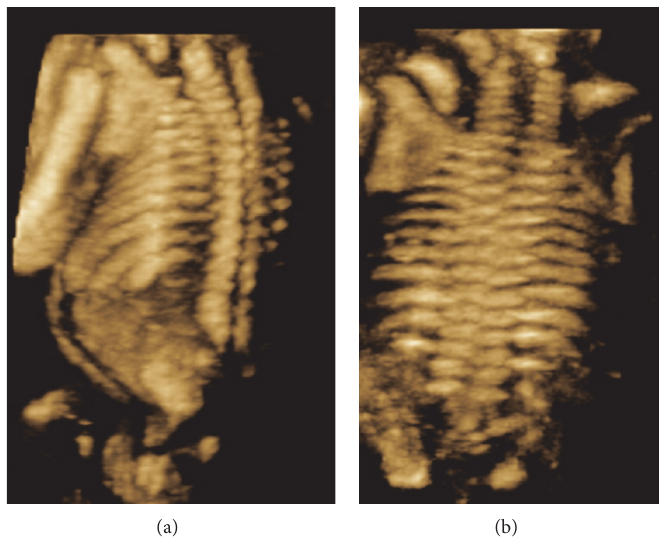
Figure 1: Three-dimensional US scans. (a) 3D rendered image of a lateral view of left upper arm, scapula, chest, and spine. The spine ends abruptly at low lumbar level and appears disconnected from the pelvic bones. (b) 3D rendered coronal image of the fetal neck and trunk. The intervertebral and intercostal spaces appear reduced creating the impression of a compressed fetal trunk.